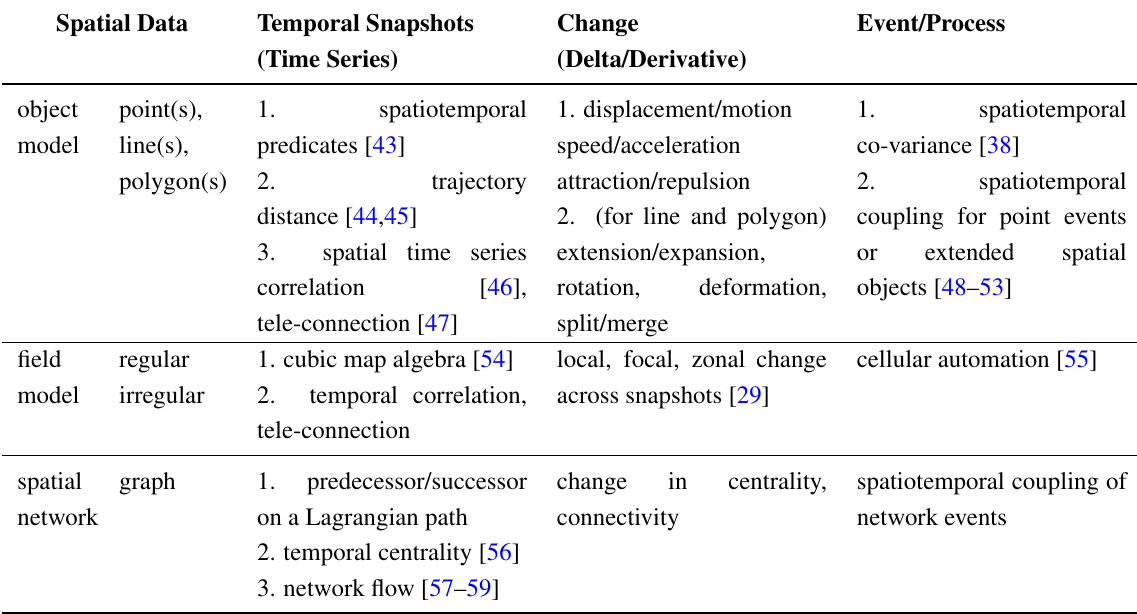
Table 3. Relationships on Spatiotemporal